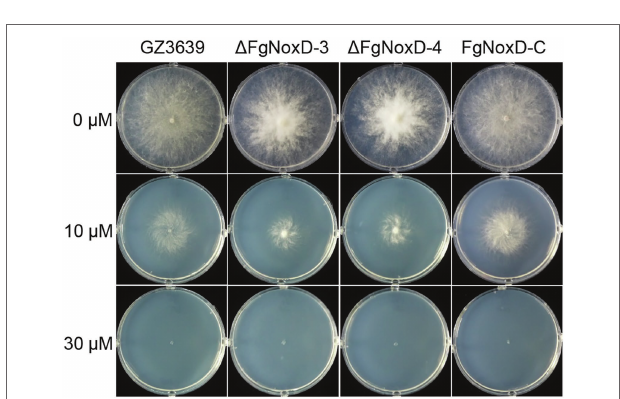
FIGURE 4 | Accumulated lipid body in GZ3639, Δ FgNoxD, and FgNoxD-C. Conidia suspension of GZ3639, Δ FgNoxD, and FgNoxD-C (1 × 10 6 conidia/ml in distilled water) were store at 4 ° C for 1 day and stained with Nile Red. White arrow depicts accumulated lipid body. Scale bar = 10 μ m.